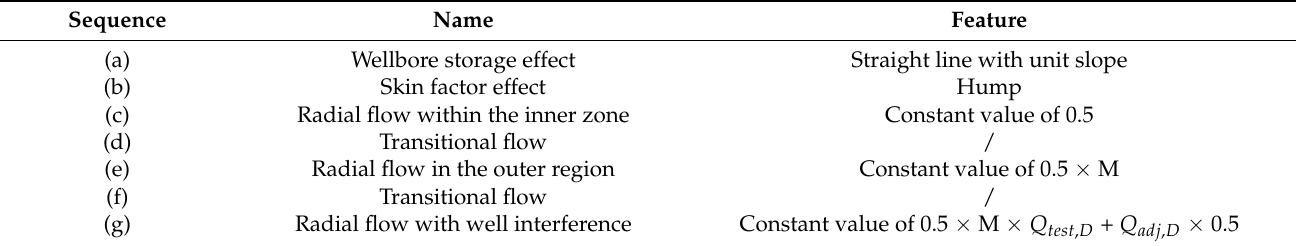
Table 4. The sequence, name, and feature of typical flow regimes in